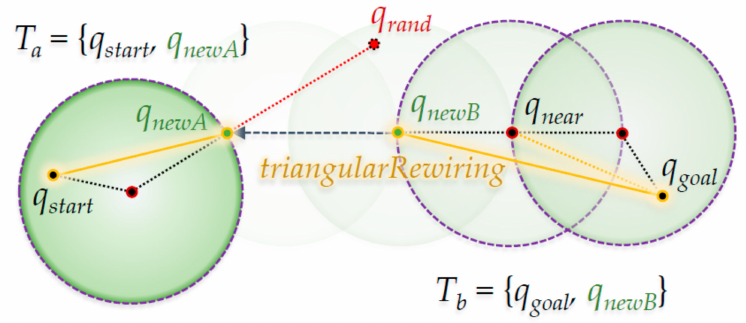
Figure 7. Proposed ‘Extend’ method for the RRT-Connect